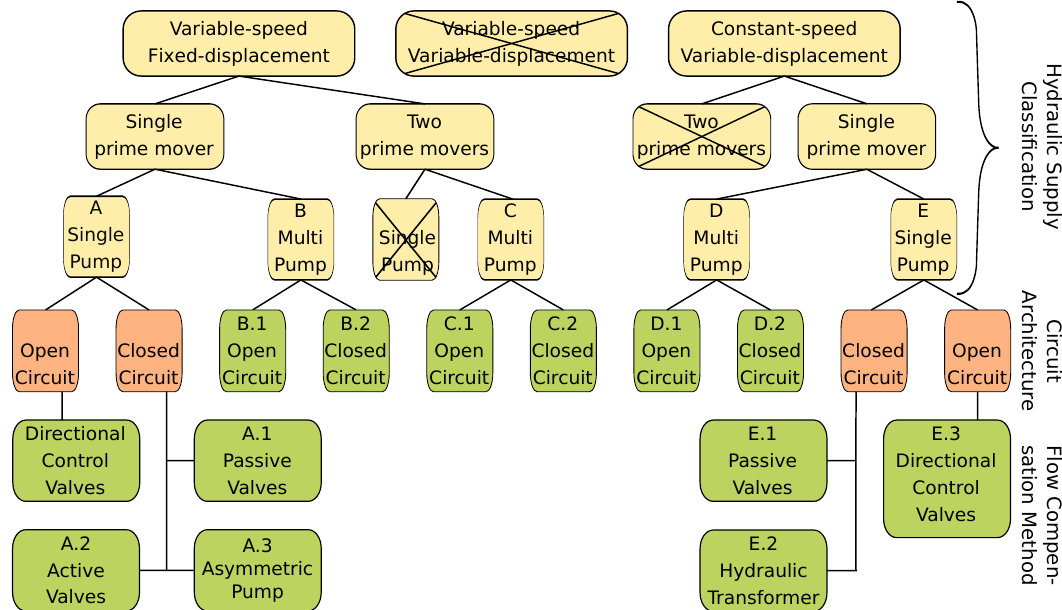
Figure 4. Proposed classification of pump-controlled differential cylinder drives. The green boxes denote classes generally functional in four quadrants: Five main classes (A–E) and 13 sub-classes are